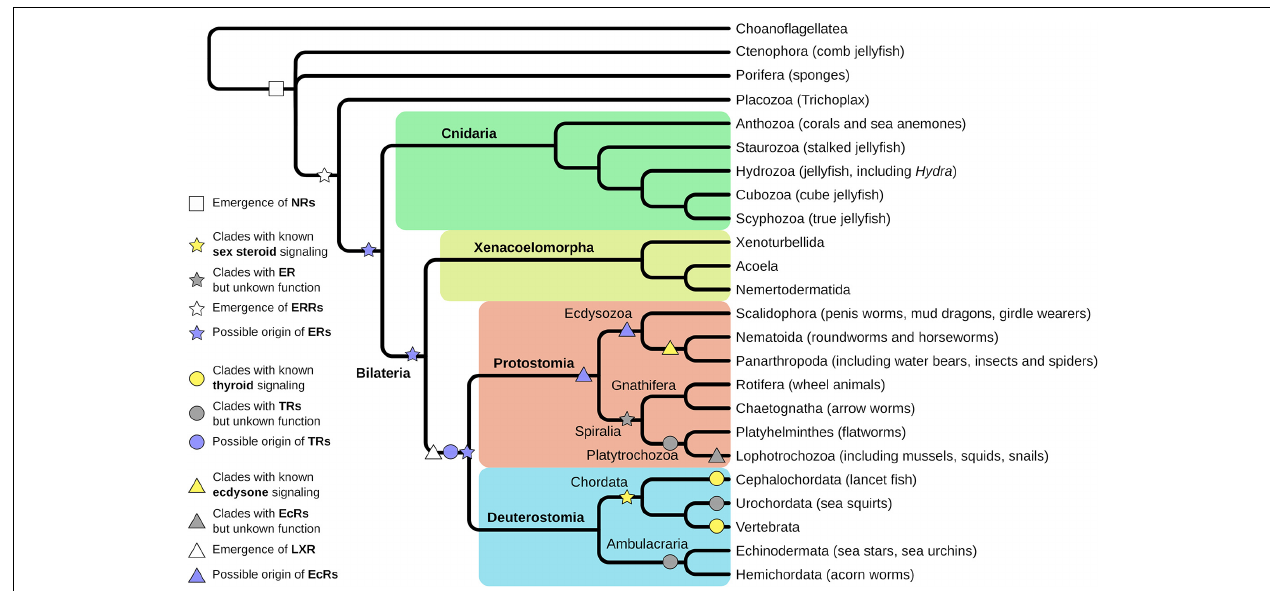
FIGURE 2 | Evolution of nuclear receptors (NRs) starts at the base of metazoan life. Porifera are the first animal clade where functional NRs emerged (white square). Trichoplax evolved an estrogen-related receptor (ERR), an orphan receptor, and close homolog to the estrogen receptor (ER) (white star). Evolution of a ligand-binding ER is proposed before the split of Protostomia and Deuterostomia, thus is located either in the Cnidarian or the Xenacoelomorpha lineage (purple star). Experimental support for ligand-binding ERs has been found in Annelida and Rotifers, thus in the Sprialia lineage within the Protostomia (gray star). Fully described and functional estrogen signaling exists in Vertebrata and Cephalochordata, thus in the Chordata lineage (yellow star). Homologs for thyroid receptors (TRs) have been identified in Lophotrochozoa, Urochordata, and Ambulacraria (gray circles) but were functionally characterized only in Cephalochordata and Vertebra (yellow circles). However, emergence of the TR was proposed at the base of Protostomia and Deuterostomia (purple circle). Ecdysone receptor (EcR) signaling has been functionally described in Panarthropoda and to some extent in Nematoida (yellow triangle) but homologs have been identified in different Lophotrochozoa (gray triangle). Hence, the emergence of EcR can be presumed at the base of Protostomia, but at least in the Ecdysozoan clade (purple triangles). The closely related LXR receptor is assumed to have emerged at the base of Protostomia and Deuterostomia (white triangle).